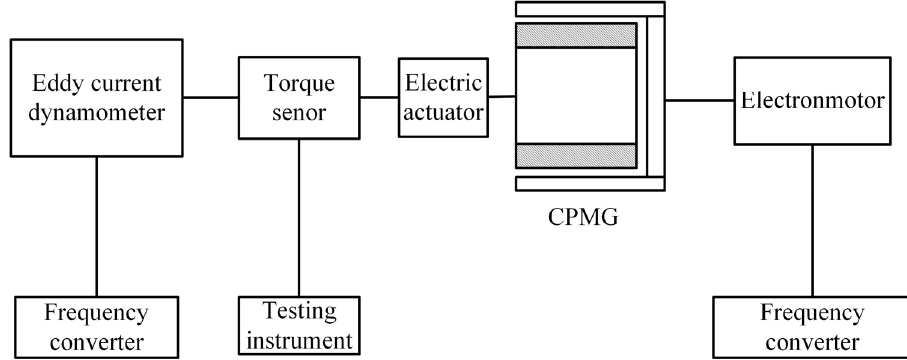
Figure 15. Basic structure diagram of test platform.